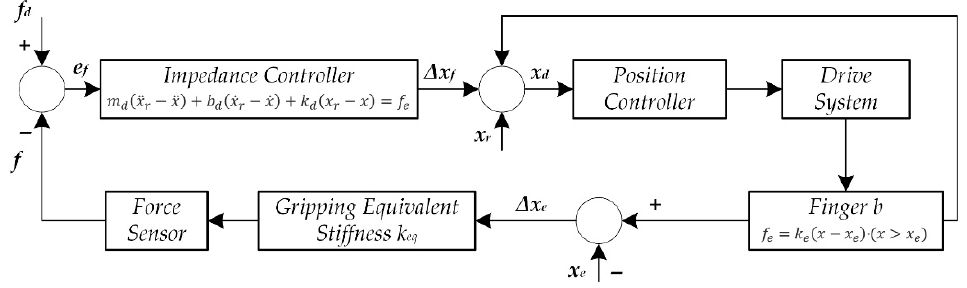
Figure 2. Impedance control diagram for gripping force of the end-effector. In the formula: m d , b d , k d , are the target inertia, damping and stiffness parameters; k e , x e , are environment stiffness and reference position; x is actual location; f e is contact force. In the picture: ∆ x e is the clamping length, f d is the set force, x r is the reference position, e f is the actual force deviation, and x d is the control input.